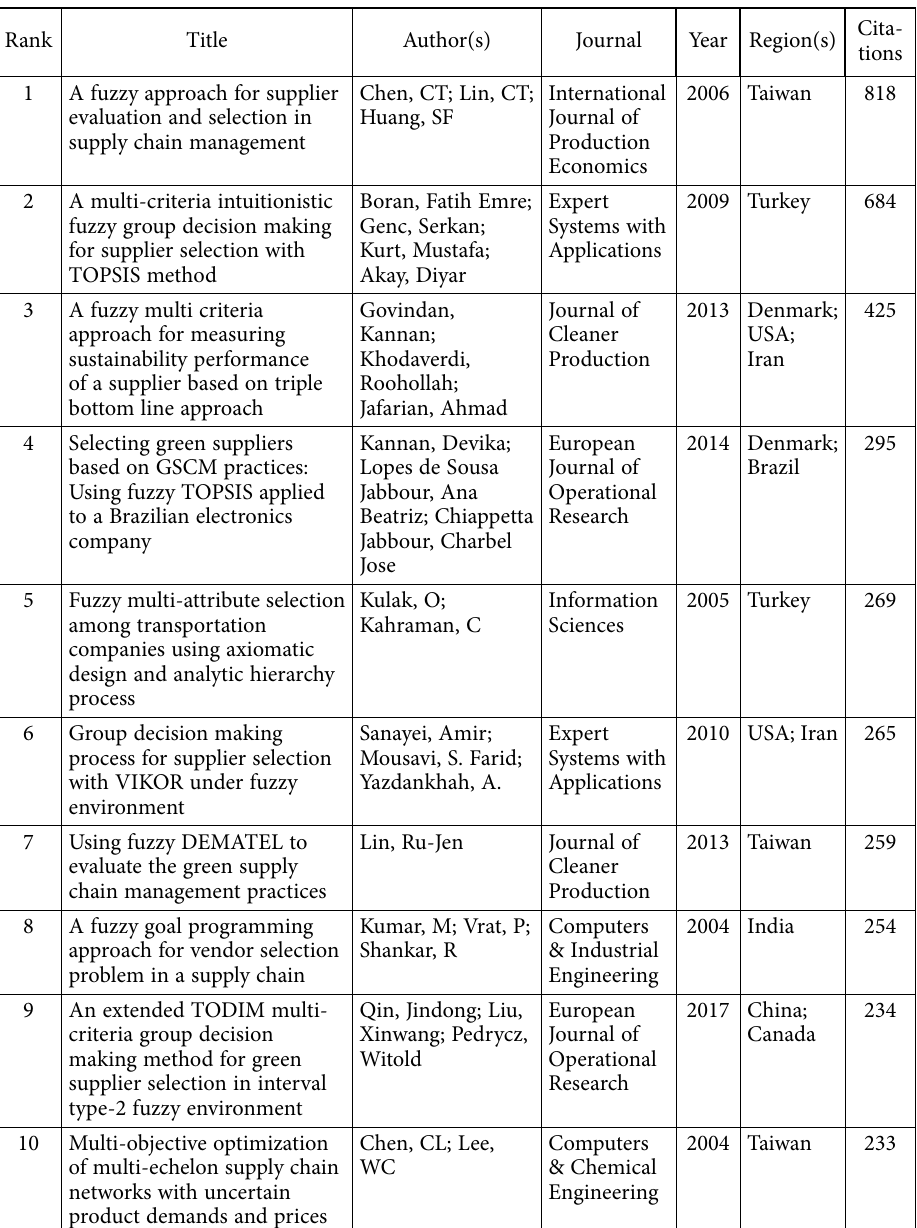
Table 5. Top 10 highly cited papers of reviewed